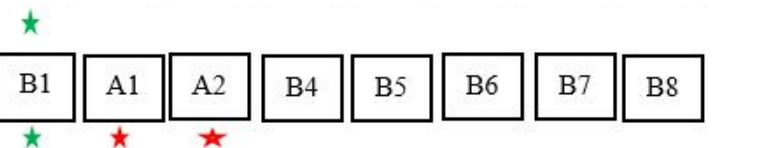
Figure 3. New individuals after CECGA (Red stars are preserved parents, green stars are the current optimal solution).